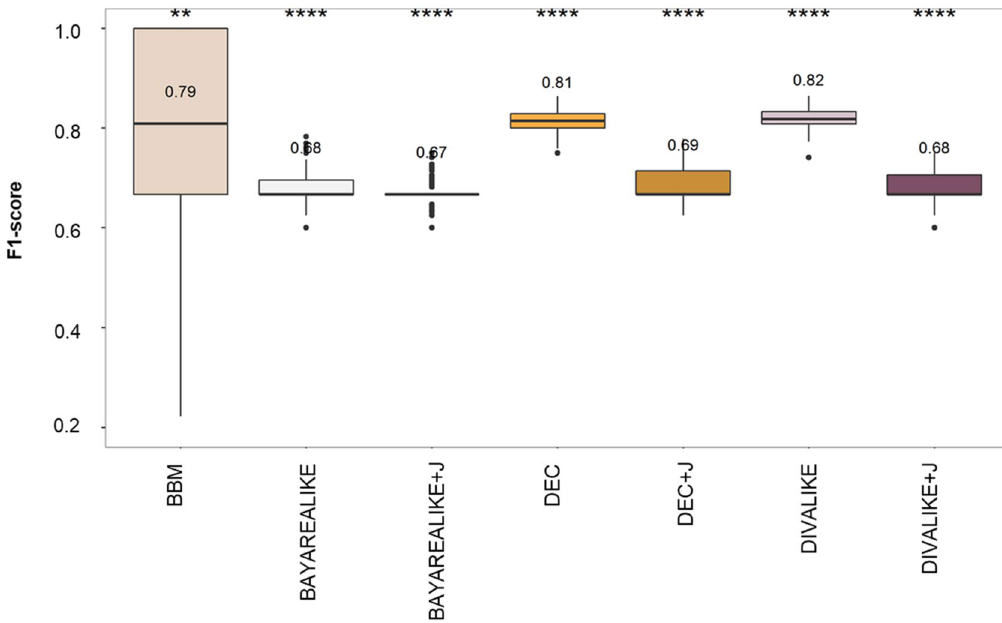
Figure 4. Performance of the seven biogeographic models used for clone migration inferences as measured by F1-scores. Mean values are depicted above the box plots. Differences in F1-scores were examined through a t -test and are marked when significant.